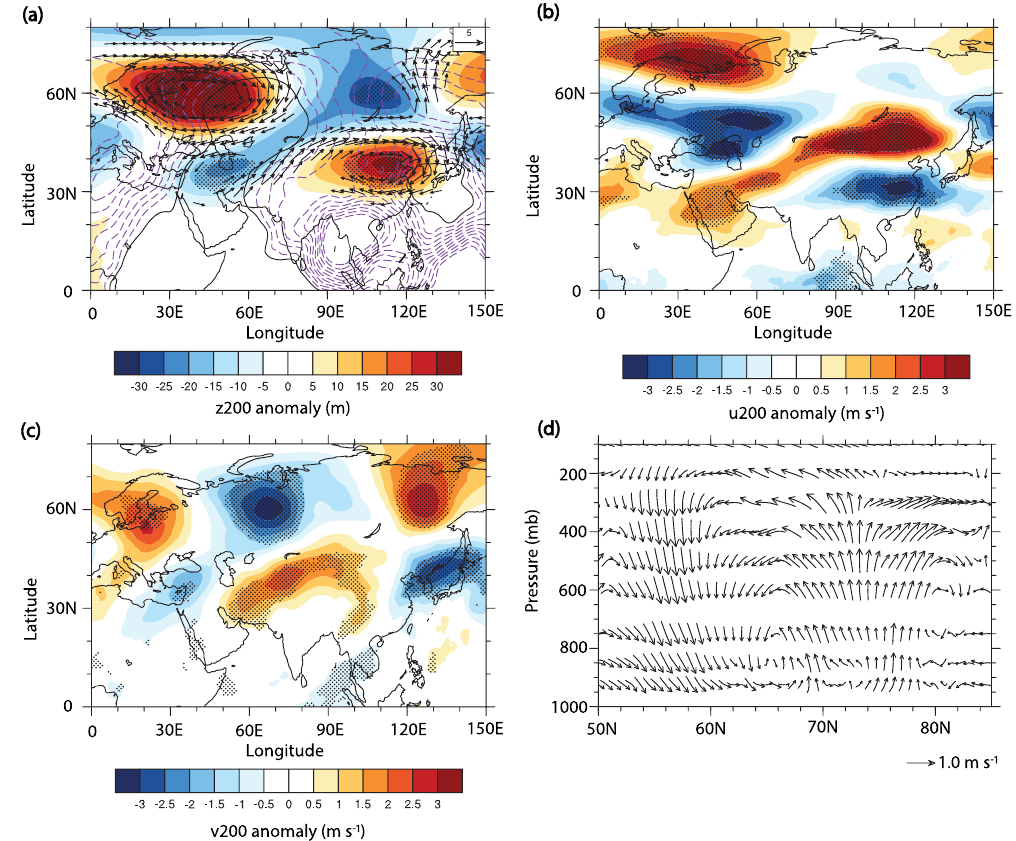
Fig. 2 Atmospheric circulation patterns associated with increased frequency of extremes rainfall events in September over central India. a Averaged difference between years with the increased (P1: 1992 – 1997 and P2: 2004 – 2010) and reduced (N1: 1986 – 1991 and N2: 1998 – 2003) extreme rainfall years in September for 200 hPa ( a ) geopotential height (m, shaded), wind (m s − 1 , vectors), velocity potential (10 6 m 2 s − 1 , contours) anomaly during August – September. Only vectors with magnitude >2 m s − 1 and negative velocity potential (indicating divergence) contours (black contour indicates the zero velocity potential contour; contour interval: 0.05) are shown for clarity. b , c Same as ( a ) but for ( b ) zonal wind anomaly (m s − 1 ) and ( c ) meridional wind anomaly (m s − 1 ). d Averaged difference in anomalous meridional circulation averaged over 30 o – 60 o E between years with the increased (P1: 1992 – 1997 and P2: 2004 – 2010) and reduced (N1: 1986 – 1991 and N2: 1998 – 2003) extreme rainfall in September. All the monthly anomalies are calculated based on 1979 – 2017 monthly climatology. Signi fi cant differences at 90% level from two-tailed t -test are dotted in ( a ) – ( c ). The vertical velocity component in ( d ) is multiplied by 1000 to scale with the